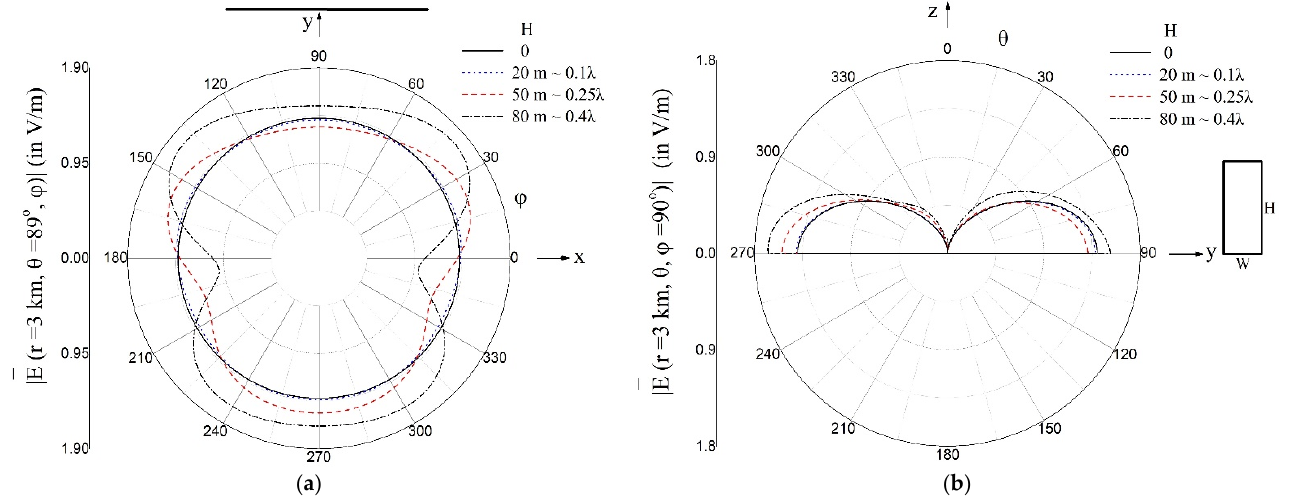
Figure 7. The same as Figure 6, except for the building size ( L = 10 m ≈ 0.05 λ and W = 60 m ≈ 0.3 λ ). ( a ) ϕ -plane and ( b ) θ -plane.